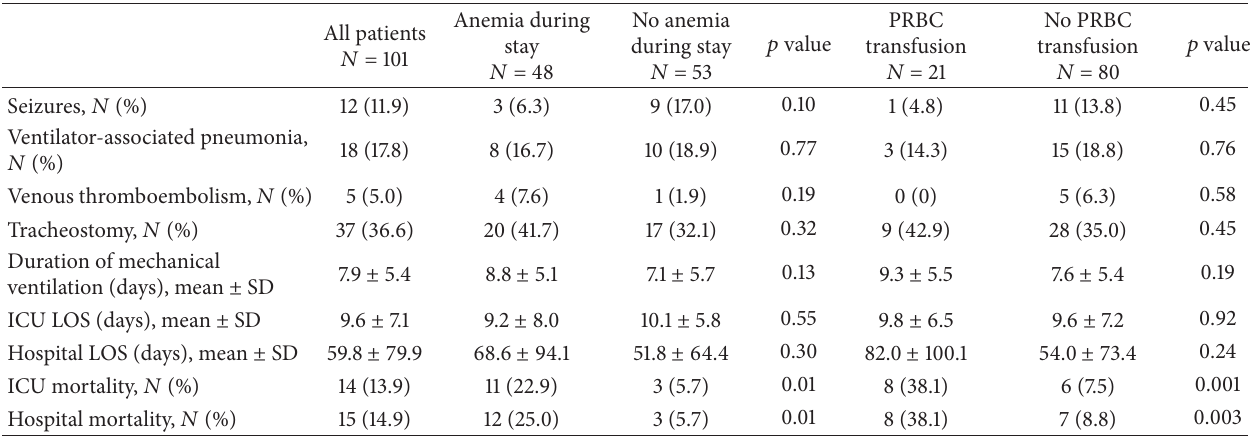
Table 2: Outcomes of patients according to the occurrence of anemia (nadir hemoglobin less than 10g/dL) during stay in the intensive care unit and PRBC transfusion status.